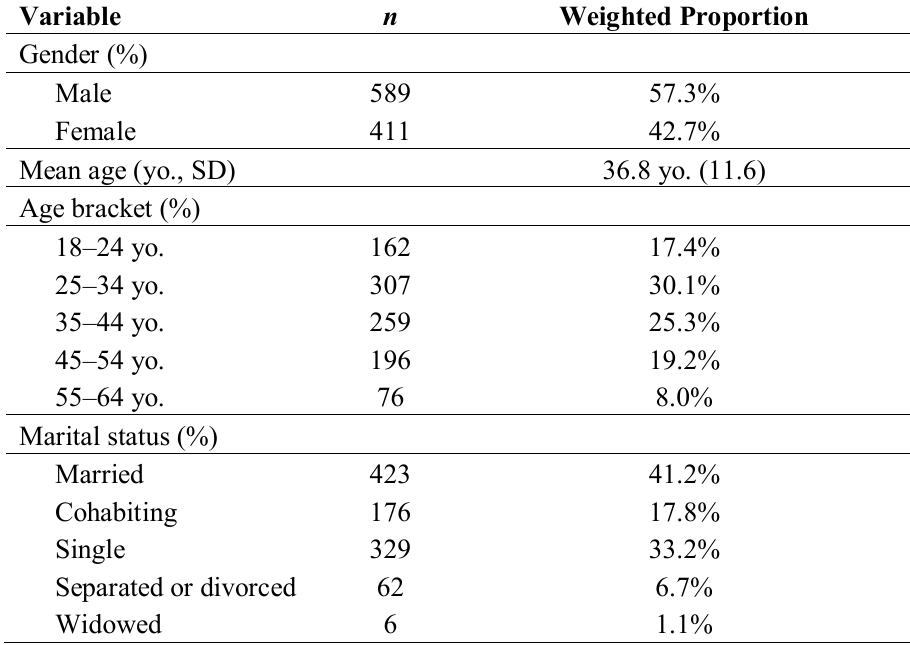
Table 1. Demographic characteristics of the participants ( n =